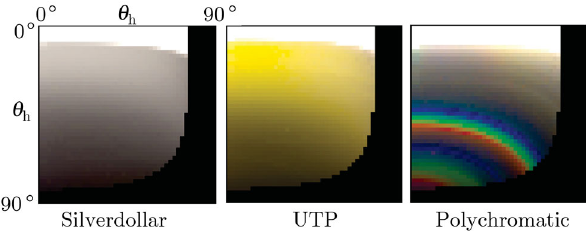
Fig. 6 Characteristic BRDF slices obtained by averaging along spatial coordinates for tested materials. The vertical axis corresponds to θ h , the horizontal axis to θ d (1471